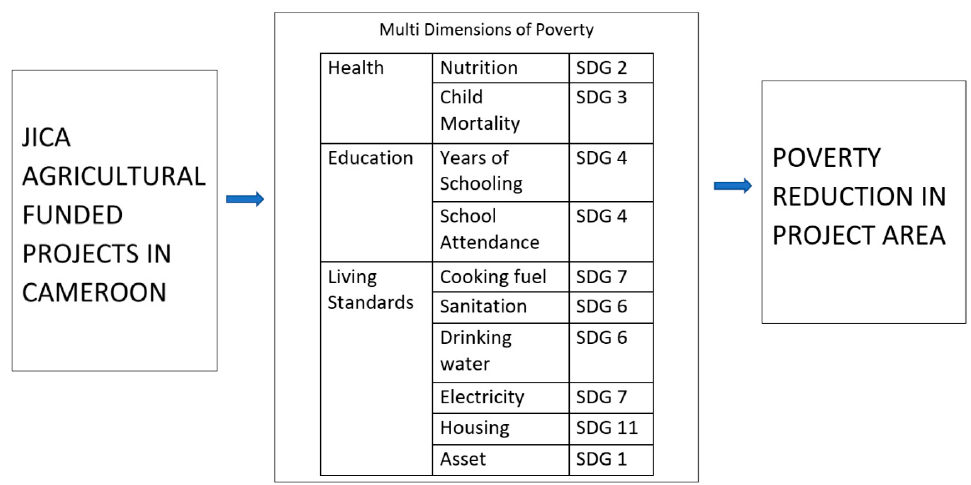
Figure 1. Contribution of JICA’s agricultural projects to multi-dimensional aspects of poverty re ‐ duction.